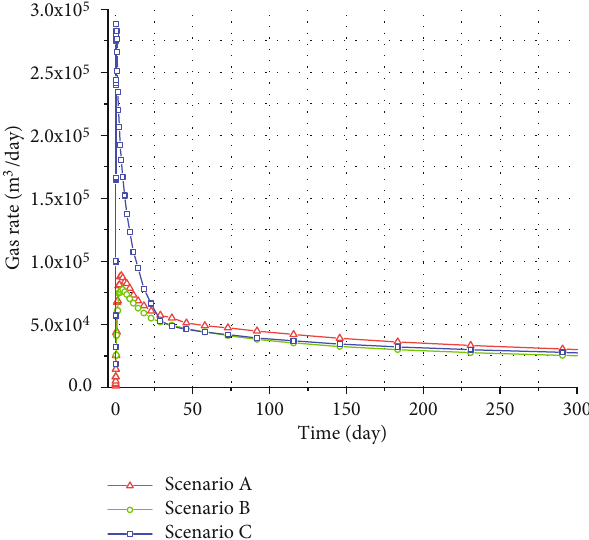
Figure 12: Gas production ratios of the three scenarios.